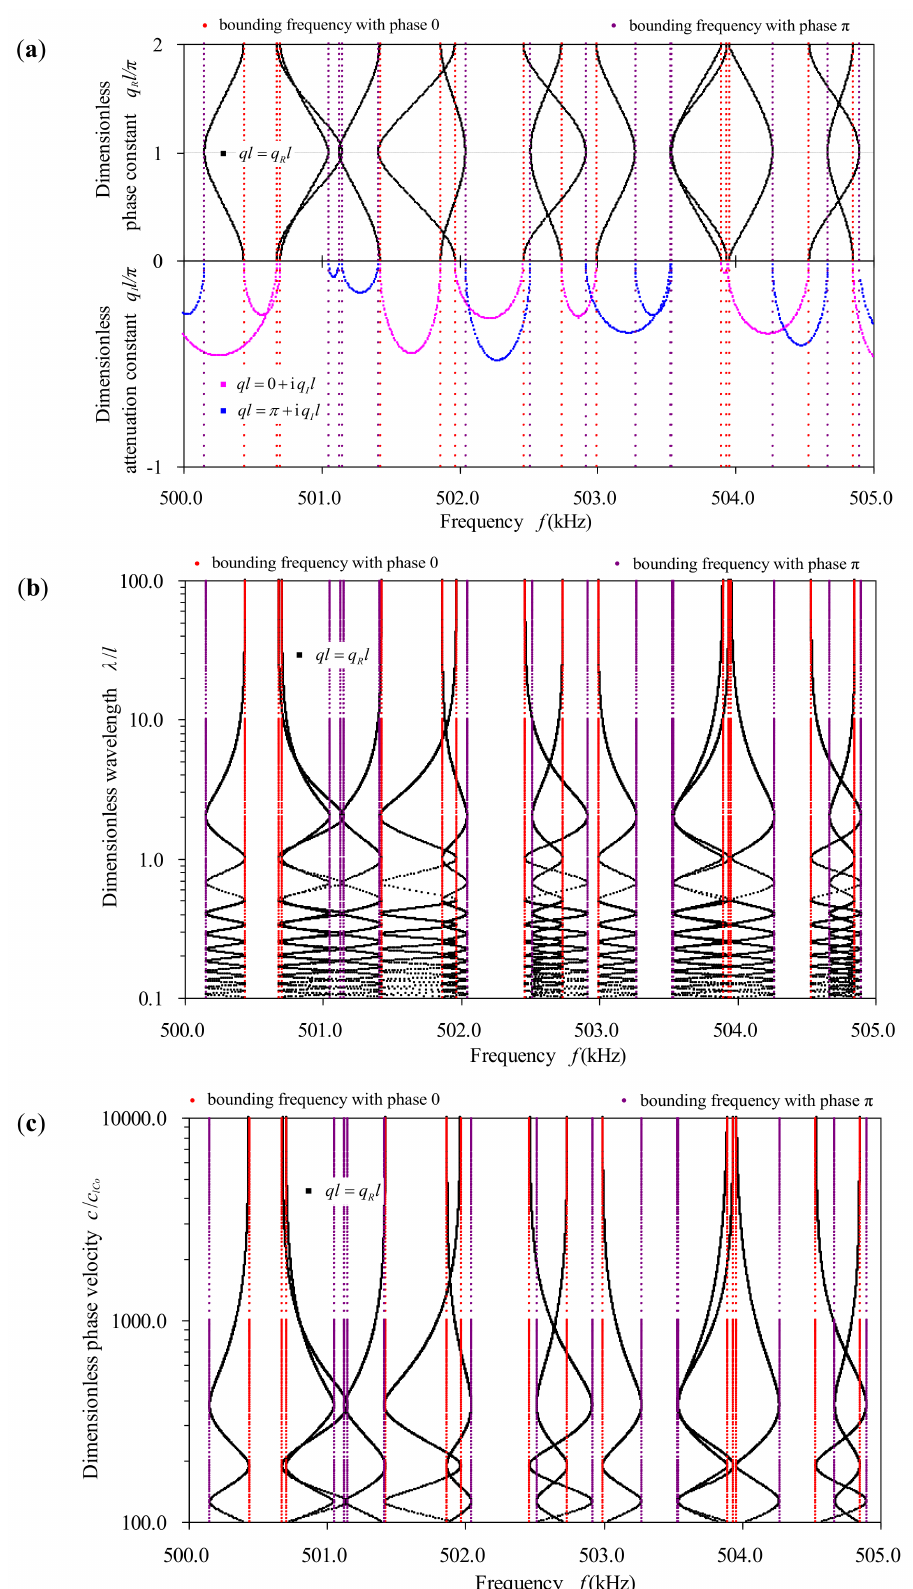
Figure 8. Frequency-related dispersion curves of bending waves in the bi-coupled periodic beam with Ternary-I unit cell within frequency range 500–505 kHz: ( a ) the phase constant and the attenuation constant spectra; ( b ) the wavelength spectra; ( c ) the phase velocity